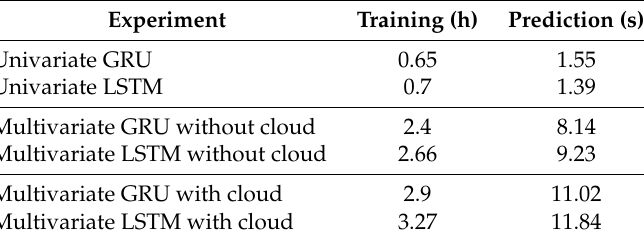
Figure 5. Comparison of actual and forecast values for both LSTM and GRU models on days with irregular solar irradiance patterns. Table 2. Comparison of training and prediction